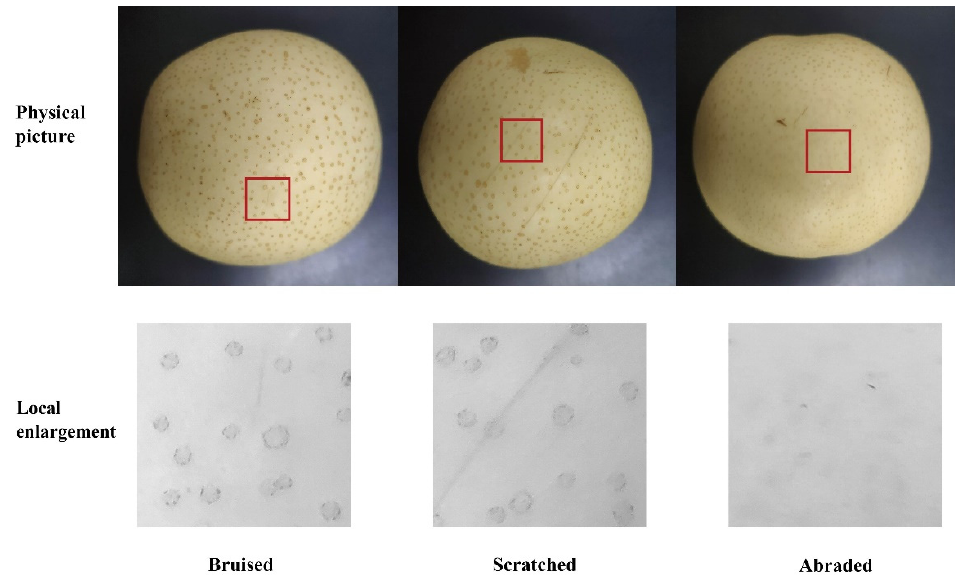
Figure 3. Bruised, scratched and abraded pears and the corresponding local enlargements.